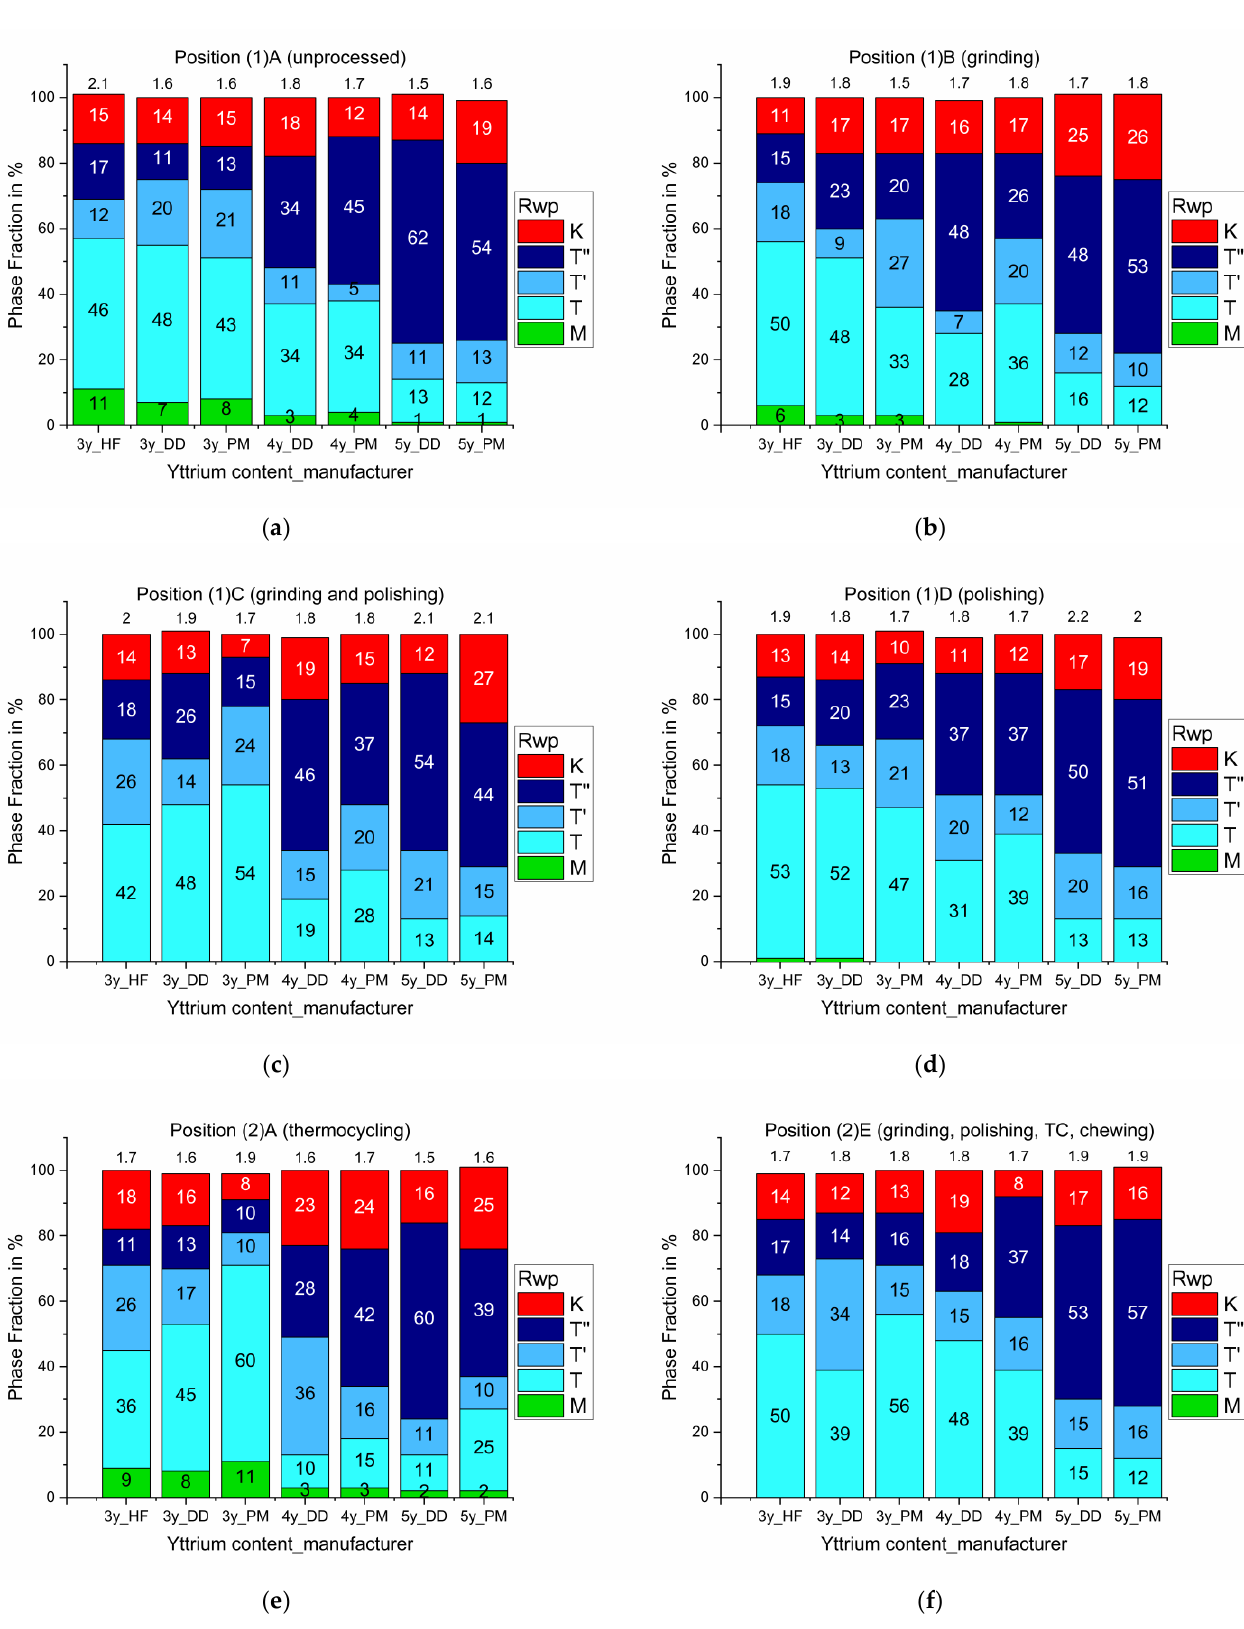
Figure 6. Comparison of six different measurement positions with their individual phase fractions and Rwp values: ( a ): baseline, ( b ): grinding, ( c ): grinding and polishing, ( d ): polishing, ( e ): thermocycling, ( f ): grinding, polishing, thermocycling, and chewing).